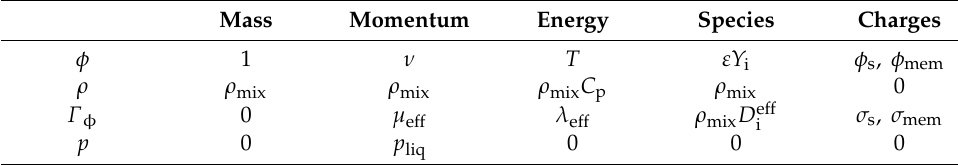
Table 1. ρ , φ , Γ φ of different governing